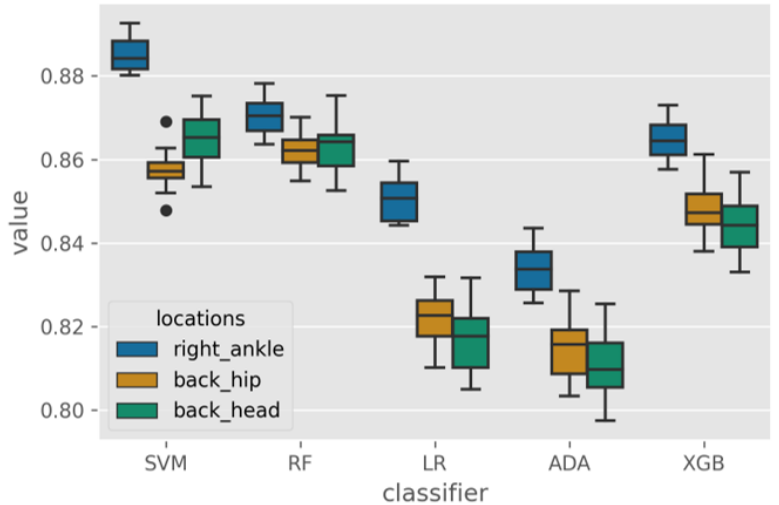
Figure 6. Box plot of the AUC across classifiers and locations.